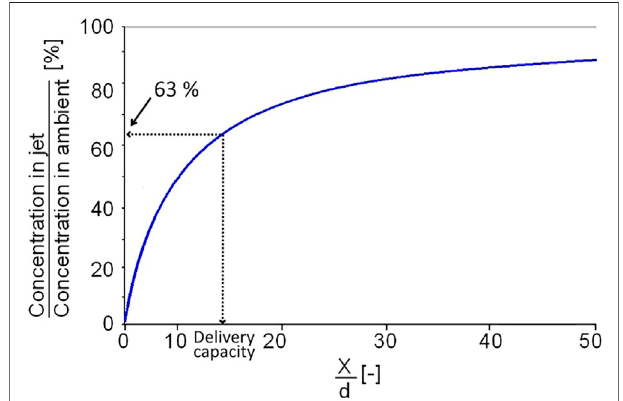
FIGURE 9 | Determination of the delivery capacity. The hatched line shows the position where the fl ow rate in the jet is q(x) ≈ 2 . 7 q ( 0 ) , which is an indicator of the delivery capacity.